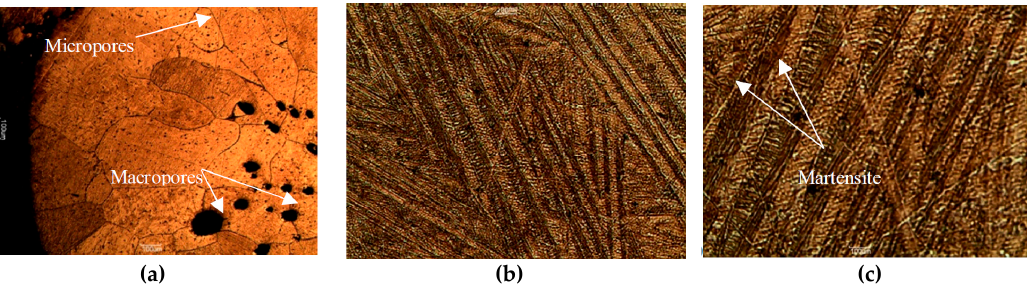
Figure 6. ( a ) Microstructure of alloy Cu-14.2%Al-2%Ni fabricated at the relative pressure of 2 bar and observed at 50 × magnification. ( b ) Microstructure of alloy Cu-14.2%Al-3%Ni fabricated at the relative pressure of 1 bar and observed under polarized light at 500 × magnification. ( c ) Same as ( b ) but observed at 1000 × magnification.